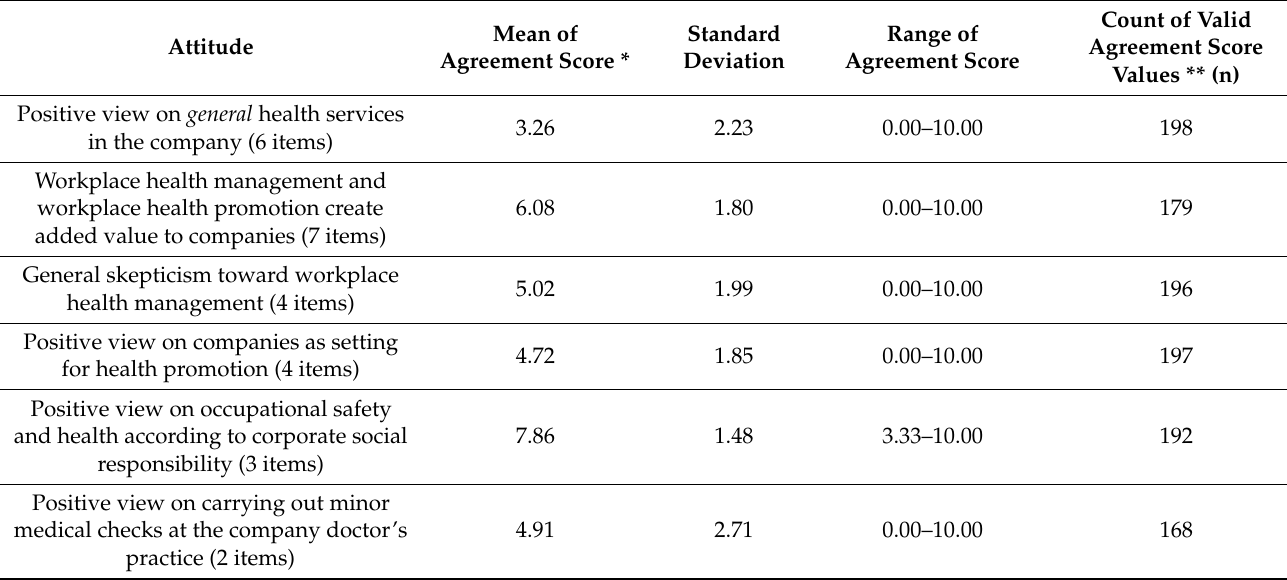
Table 5. Standardized agreement with six attitudes toward workplace health management (minimum agreement: 0, maximum agreement: